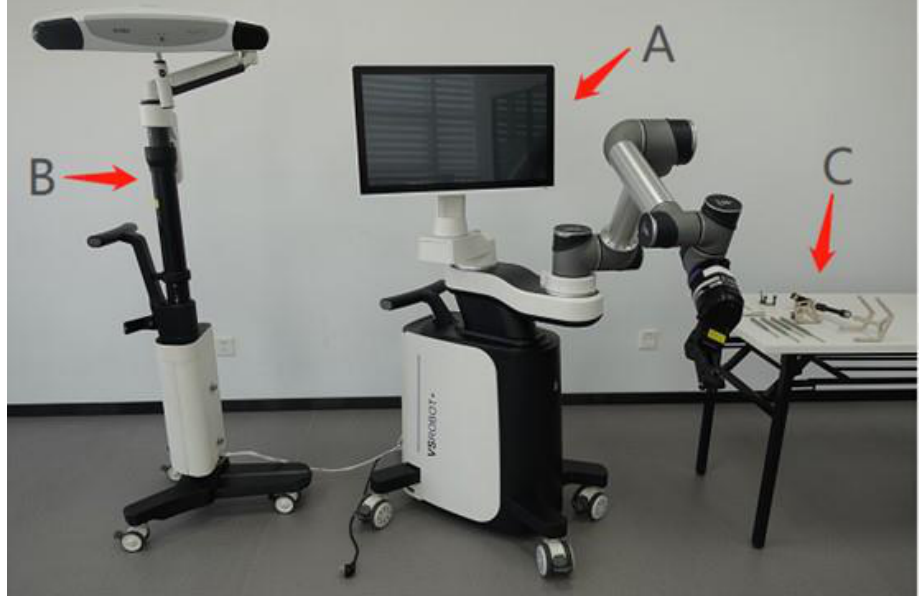
Figure 1. Robotic base station (A), optical tracking system (B), and toolset (C).